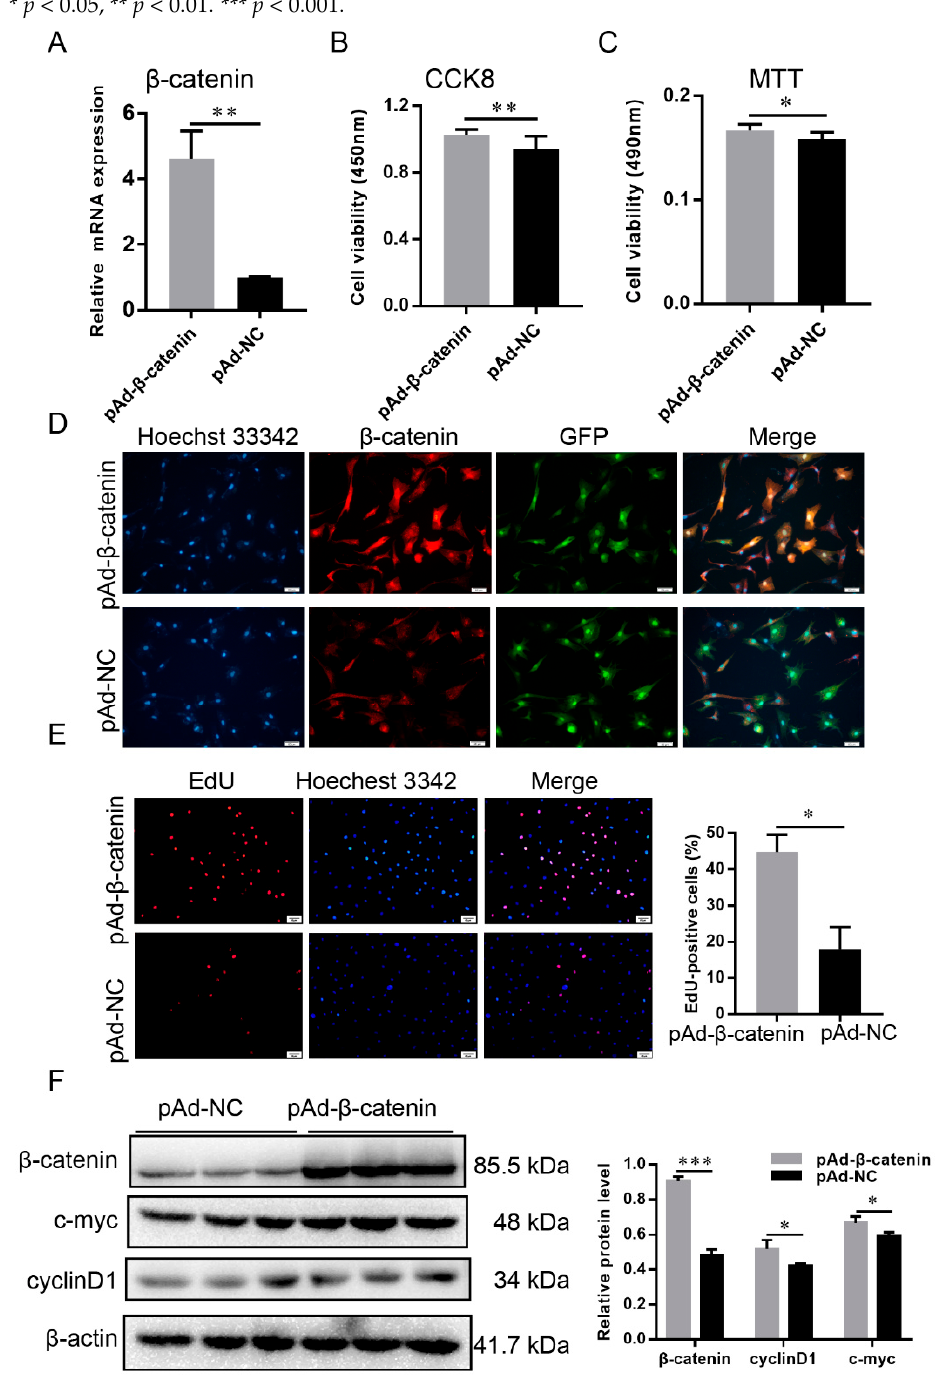
Figure 5. β -catenin promoted dermal papilla cell proliferation. ( A ) RT-qPCR detected the effect